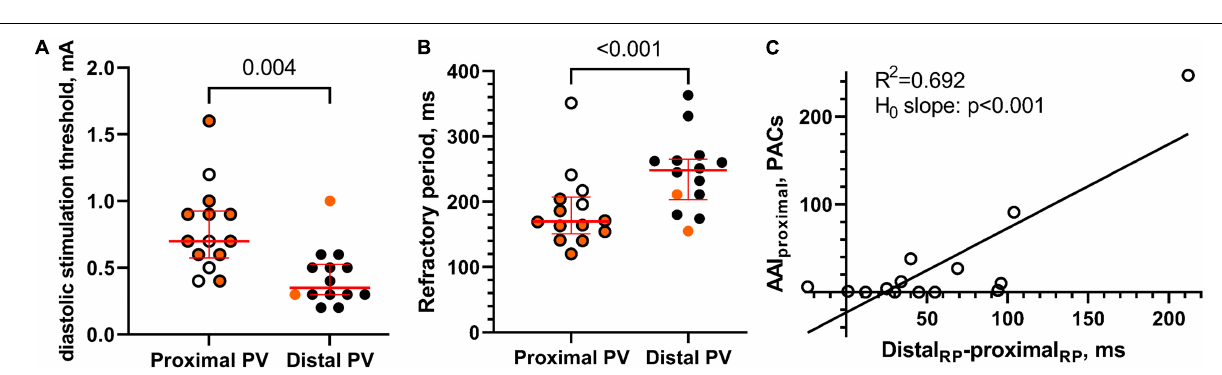
FIGURE 7 | Excitability and refractoriness. (A) The diastolic stimulation threshold was higher in the proximal PV than in the distal PV, thereby indicating lower excitability in the proximal PV. Orange color indicates that atrial arrhythmias were induced by local pacing. (B) The refractory period was shorter in the proximal PV than in the distal PV. (C) A statistically significant linear relation between AAI in the proximal PV and the distal-proximal difference in PV refractory period (RP), n =